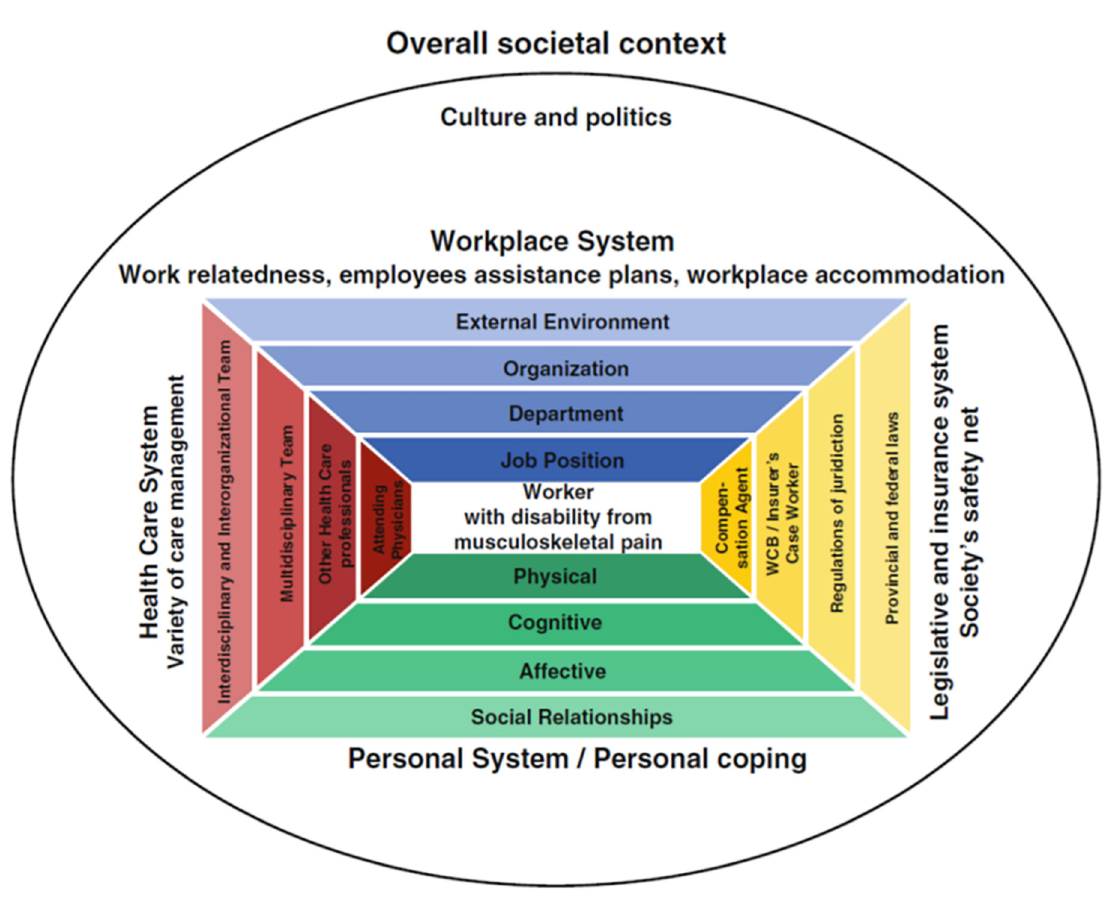
Figure 2. The arena of work disability model. Reprinted by permission from Springer Nature Cus- tomer Service Centre GmbH, Journal of Occupational Rehabilitation, Prevention of Work Disability Due to Musculoskeletal Disorders: The Challenge of Implementing Evidence, Loisel et al., [48].